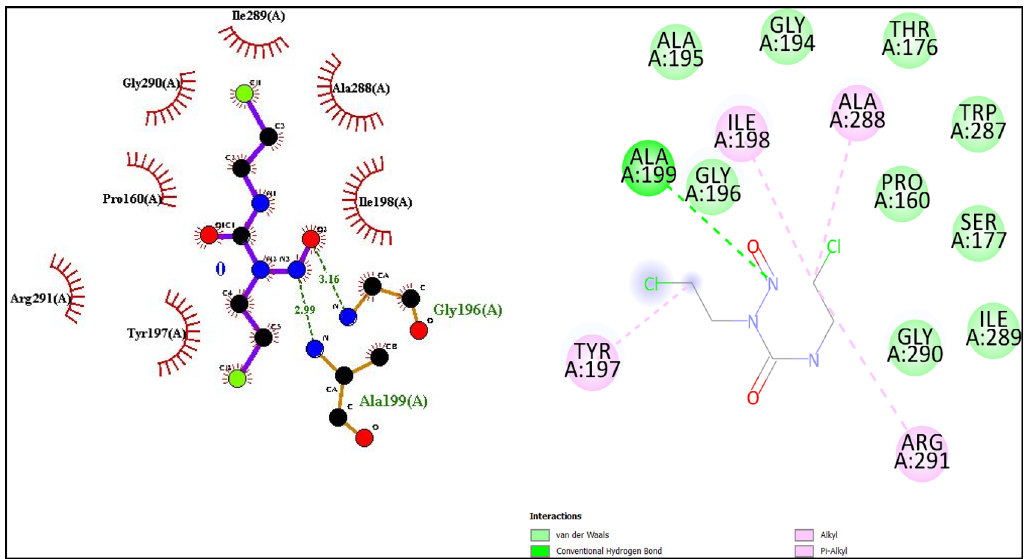
Figure 2. ( a ) Binding pocket of carmustine showing the hydrophobic pocket ( b ) types of carmustine-residue interactions.